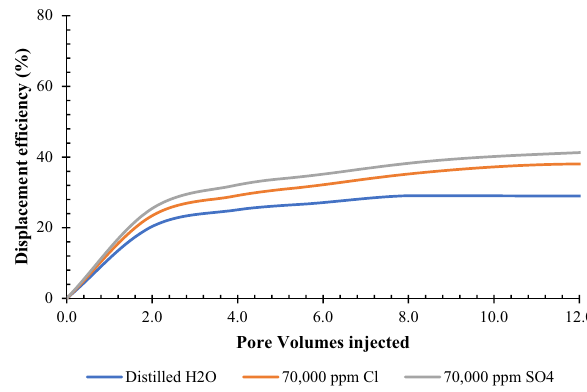
Fig. 10 Comparison of displacement efficiencies of high-salinity